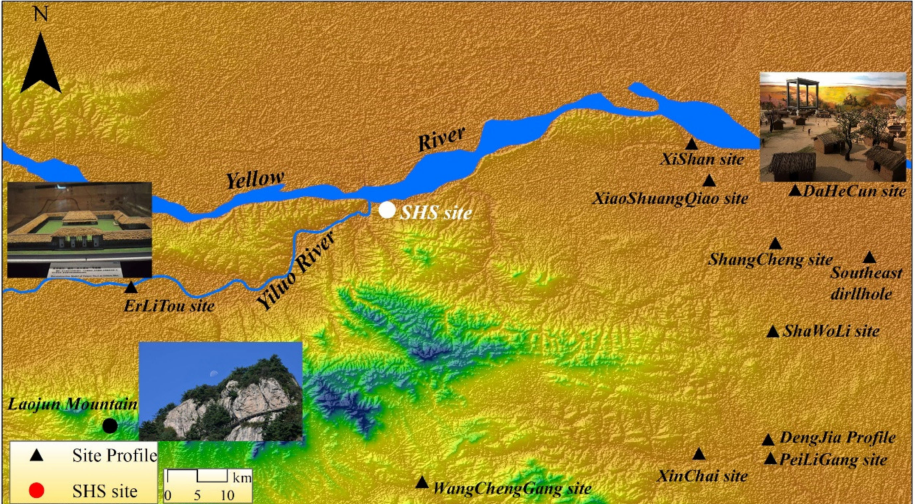
Figure 6. Locations of the collected profile